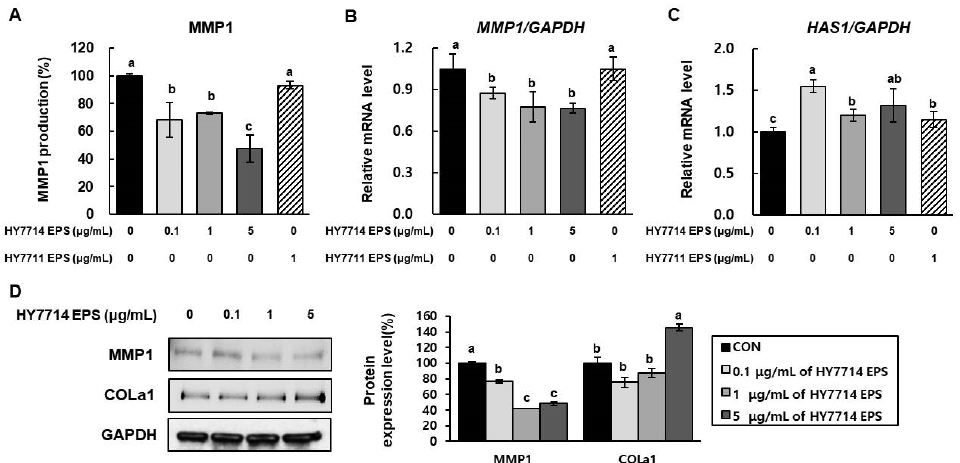
Figure 3. Effect of HY7714 EPS on ECM modulation in HS68 cells. ( A ) The intracellular level of matrix metalloproteinase1 (MMP1) in HS68 cells treated with HY7714 EPS was measured using an MMP1 ELISA kit. ( B , C ) Relative mRNA levels of MMP1 and HAS1 in HS68 cells were calculated by qPCR and normalized against GAPDH. ( D ) Western blotting for MMP1 and COLa1 in HS68 cells, and quantification of band density. Data are expressed as means ± SD ( n = 4), and values labeled with different letters are significantly different, p < 0.05 (a > b > c). CON, control cells.